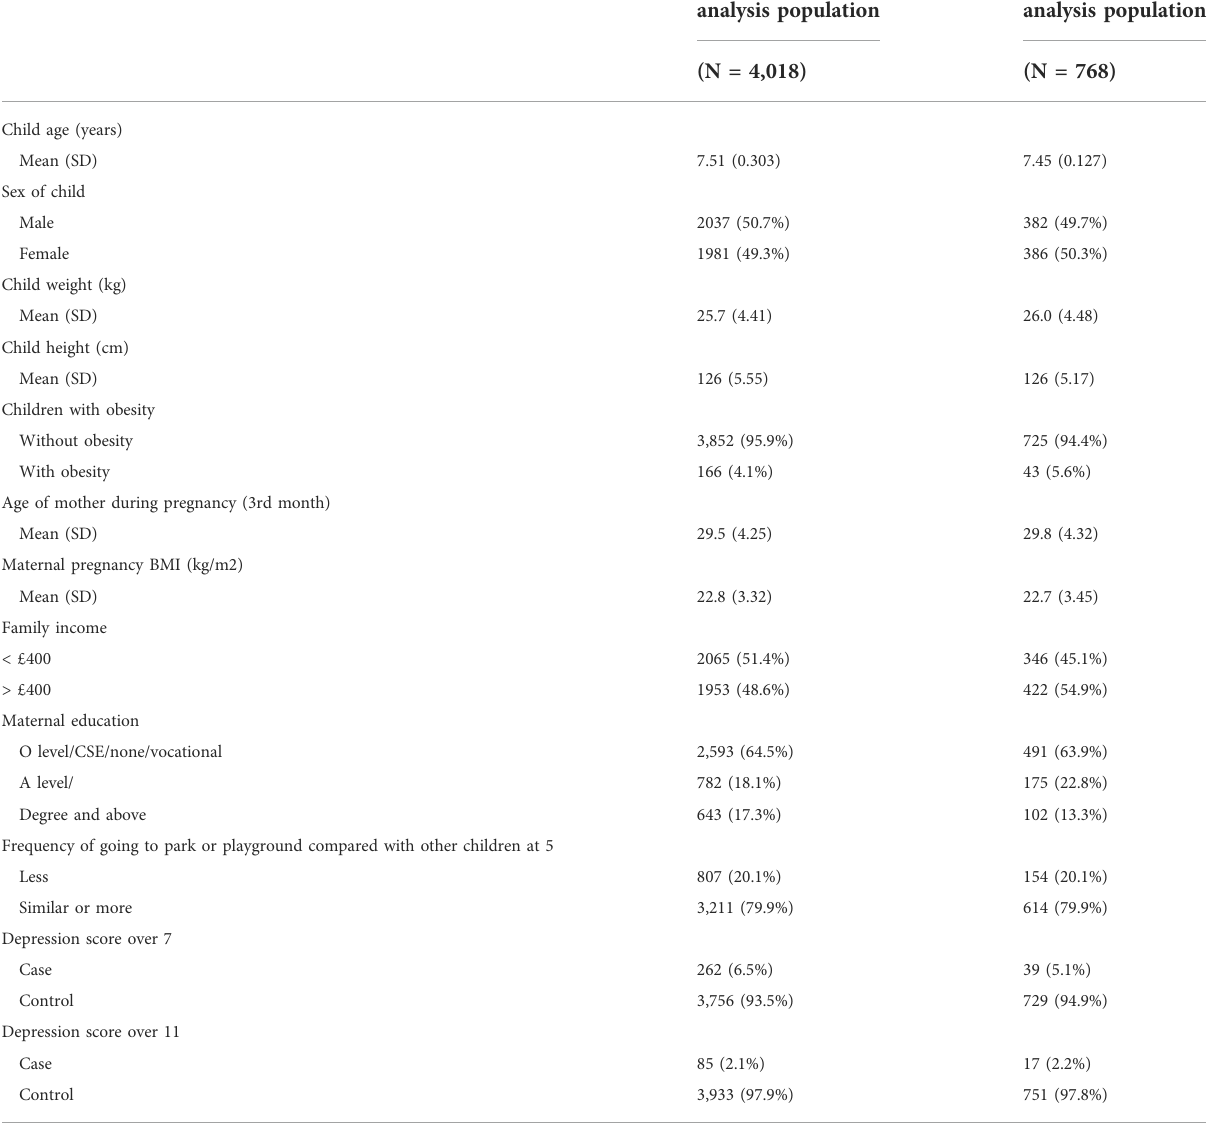
TABLE 1 Descriptive statistics in study population with metabolomic and epigenetic data